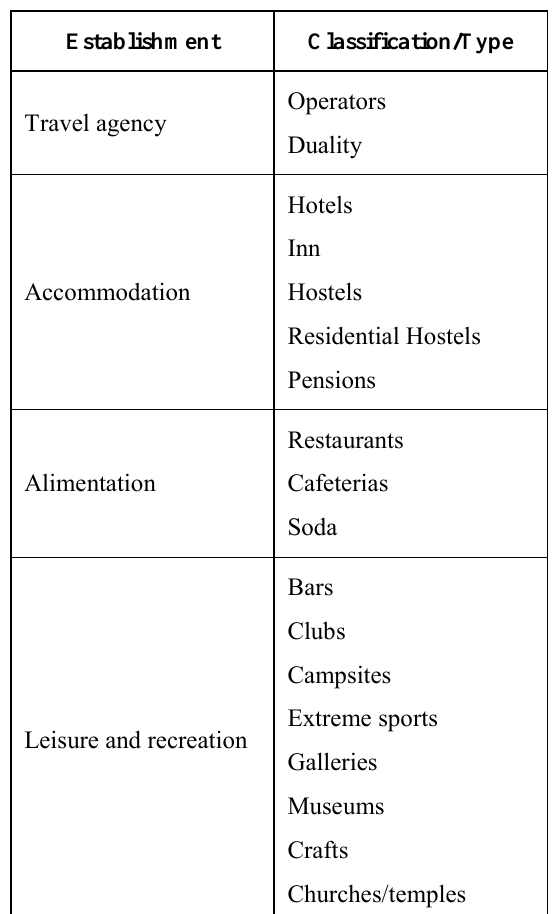
Table 1: Service